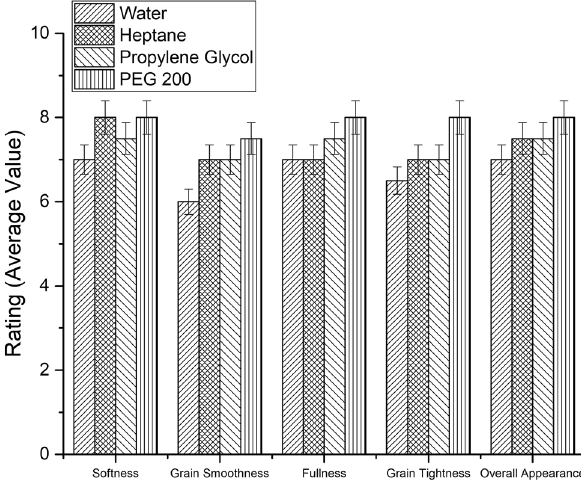
Figure 8. Organoleptic properties of control and experimental crust leathers.